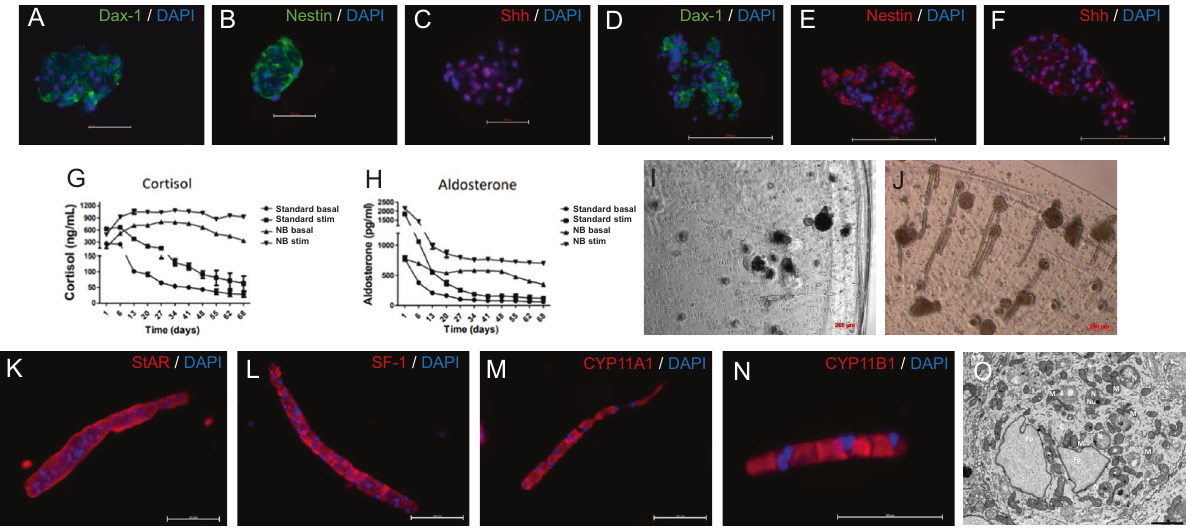
Fig. 7 Investigation of healthy bovine and porcine derived adrenal 3D-cultures. Spheroids from bovine ( A – C ) and porcine ( D – F ) adrenals stained with antibodies against DAX1, Nestin and SHH. Effect of growth media on the secretion of cortisol G or aldosterone H into the supernatant of porcine adrenal spheroids (3 experiments with 4 replicates each). Images of porcine spheroids I or spheroids treated with ATCH J highlight the presence of multicellular extensions following ACTH stimulation. Multicellular extensions expressed the markers StAR, SF-1 CYP11A1 and CYP11B1 ( K – N ). Electron micrograph of adrenocortical cells, migrating from the spheroid O . The cell shows characteristic features of mature steroid producing cell including characteristic elongated and round- shape mitochondria (mit) with the